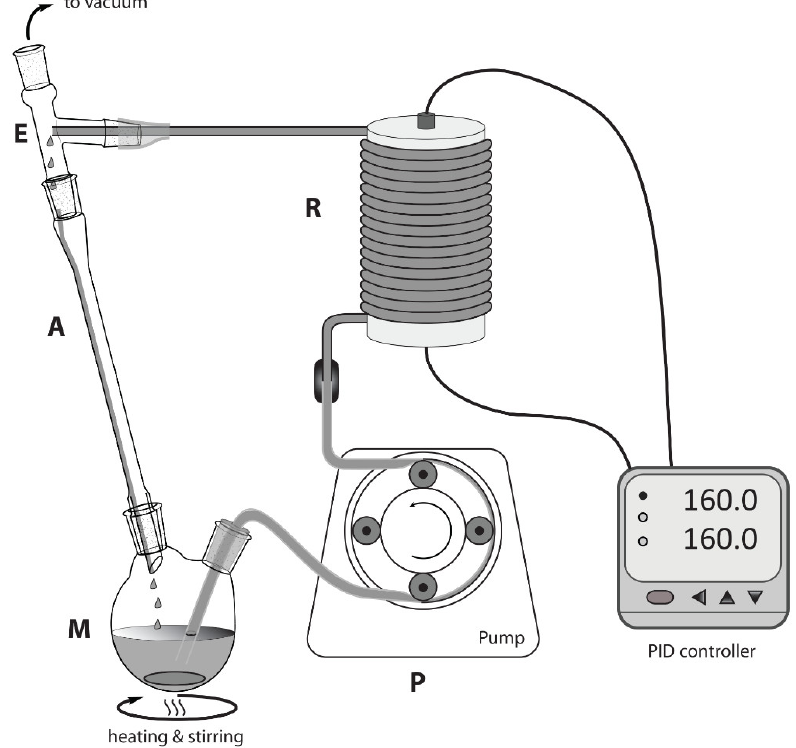
Figure 2. Layout of the continuous flow reactor. M = mixing chamber; P = peristaltic pump; R = coiled tubular reactor; E = expansion chamber; A = air-cooled condenser.